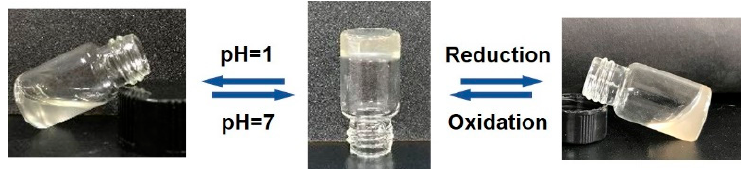
Figure 2. Digital photos demonstration of environmental responsive sol-gel transition of CMC-OSA- DTP hydrogels.